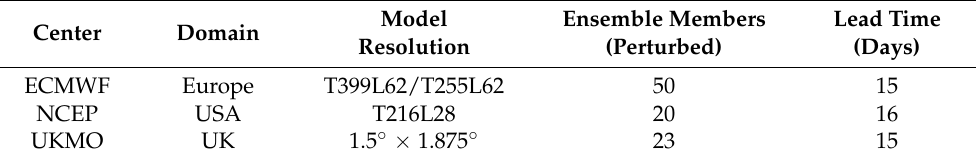
Table 1. Comparison of the three single-center ensemble prediction systems used in this study.